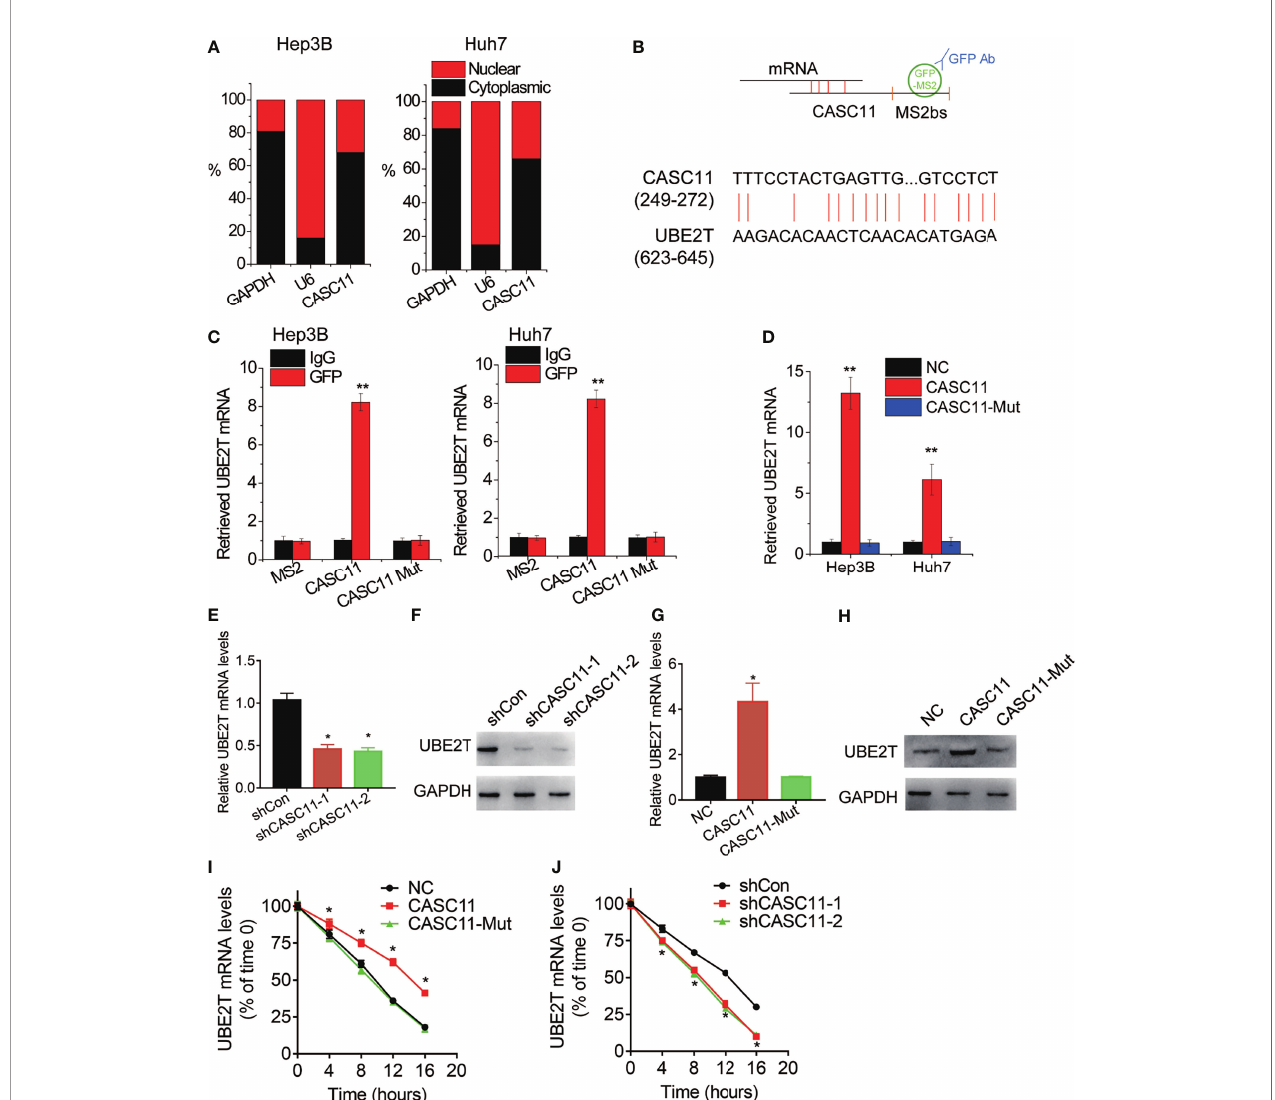
FIGURE 4 | CASC11 associates with and stabilizes UBE2T mRNA. (A) The cellular distribution of CASC11 was analyzed. (B) The schematic diagram of MS2bs- MS2bp-based RIP (MS2-RIP) experiment (up). The region of putative interaction between CASC11 and UBE2T mRNA was shown (down). (C) The UBE2T mRNA associated with CASC11 was detected using MS2-RIP assay. (D) Cell lysates were incubated with biotin-labeled CASC11; after pull-down, mRNA was extracted and assessed by qRT-PCR. (E) The qRT-PCR analysis of UBE2T mRNA level in control and CASC11 knockdown Hep3B cells. (F) The western blot analysis of UBE2T protein level in control and CASC11 knockdown Hep3B cells. (G) The qRT-PCR analysis of UBE2T mRNA level in control and CASC11 overexpressing Huh7 cells. (H) The western blot analysis of UBE2T protein level in control and CASC11 overexpressing Huh7 cells. (I) Control and CASC11 knockdown Hep3B cells were treated with Actinomycin D (5 m g/ml). At different time point, the loss the UBE2T mRNA was detected using qRT-PCR. (J) Control and wild-type and mutant CASC11 overexpressing Huh7 cells were treated with Actinomycin D (5 m g/ml). At different time point, the loss the UBE2T mRNA was detected using qRT-PCR. Data are mean ± SD. *p < 0.05, **p <